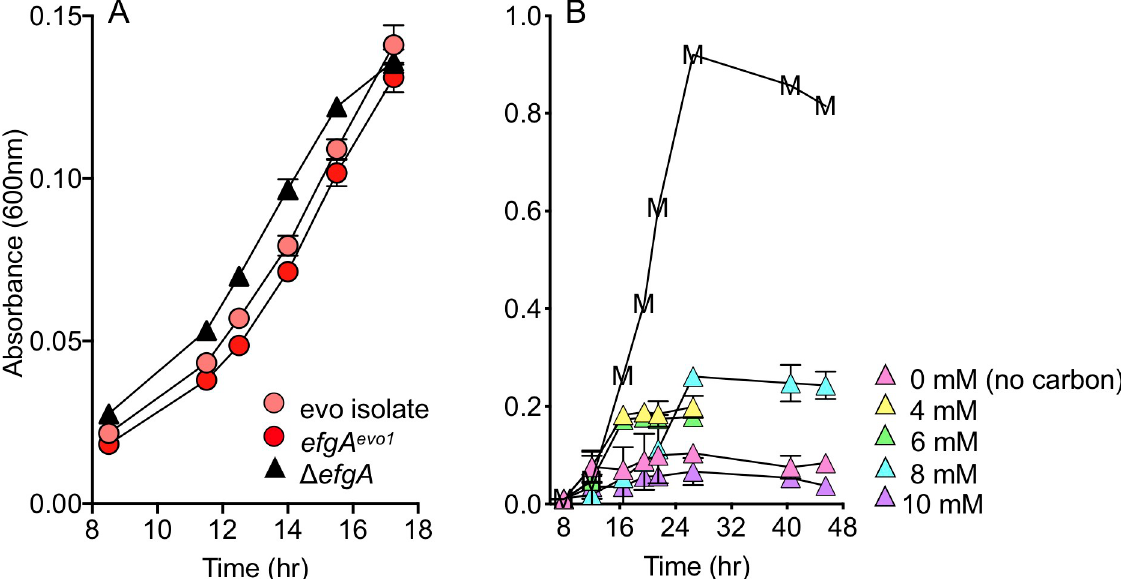
Fig 4. Evolved efgA allele or deletion of efgA recapitulates formaldehyde growth. (A) Evolved isolate (CM3035, pink), reconstructed efgA evo1 mutant (CM3793, red), and Δ efgA mutant (CM3745, black triangles) were grown in liquid Hypho medium with 5 mM exogenous formaldehyde as a sole source of carbon and energy. (B) The Δ efgA mutant strain was grown in liquid MP medium with 0 (i.e., no carbon), 4, 6, 8, or 10 mM exogenous formaldehyde as a sole source of carbon and energy. For comparison, representative growth with 15 mM methanol (no formaldehyde) is shown (“M”). Error bars represent the standard error of the mean of three biological replicates. In Panel A, only the exponential phase of growth is depicted; in Panel B, measurements are stopped upon entry into stationary phase. The original data shown in this and all other figures are available in Supporting information file S1